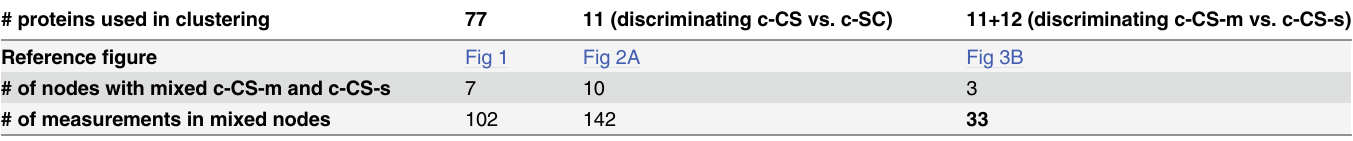
Table 4. Numbers of mixed c-CS-m and c-CS-s nodes and measurements. # proteins used in clustering 77 11 (discriminating c-CS vs. c-SC) 11+12 (discriminating c-CS-m vs. c-CS-s) Fig 1 Fig 2A Fig 3B # of nodes with mixed c-CS-m and c-CS-s # of measurements in mixed